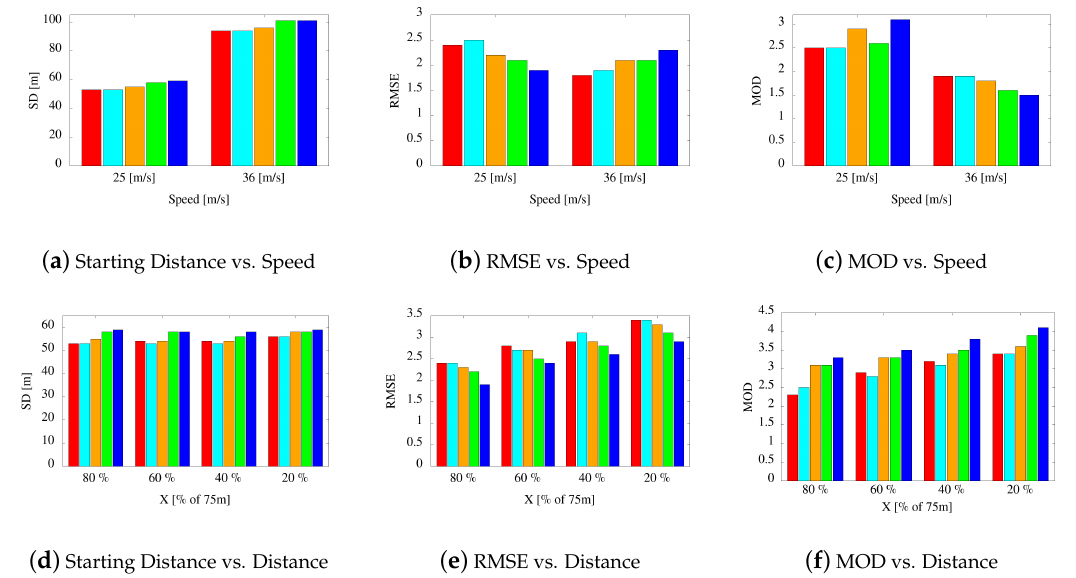
Figure 14. The elk test repeated with different speeds ( a – c ) and different distances between the two obstacles ( d – e ). The plots report the starting distance (SD) ( a , d ), the root mean square error ( RMSE ) ( b , e ), and the minimum obstacle distance (MOD) ( c , f ). The histograms report a comparison between CPU and GPU results. The red (first) column represent the CPU response with D = 6 and H = 4. All other colors represent the GPU response with: D = 6 H = 4 (second column, cyan), D = 5 H = 5 (third column, orange), D = 4 H = 6 (fourth column, green), and D = 5 H = 6 (fifth column,